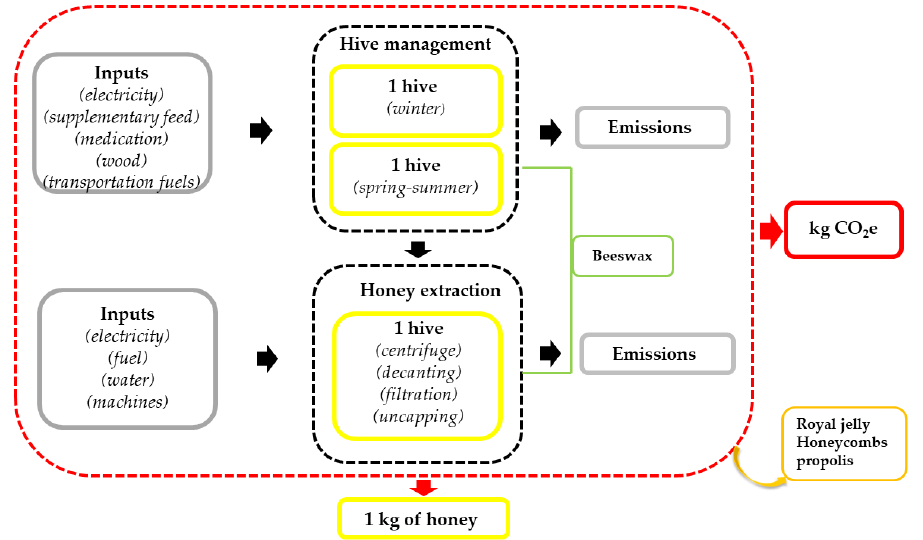
Figure 1. Flowchart of the boundary and main activity for the LCA beekeeping chain.